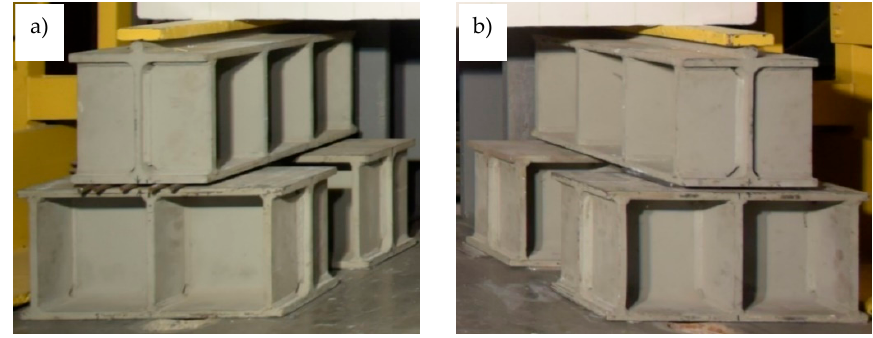
Figure 9. Beam supports: ( a ) roller support, ( b ) pinned support.